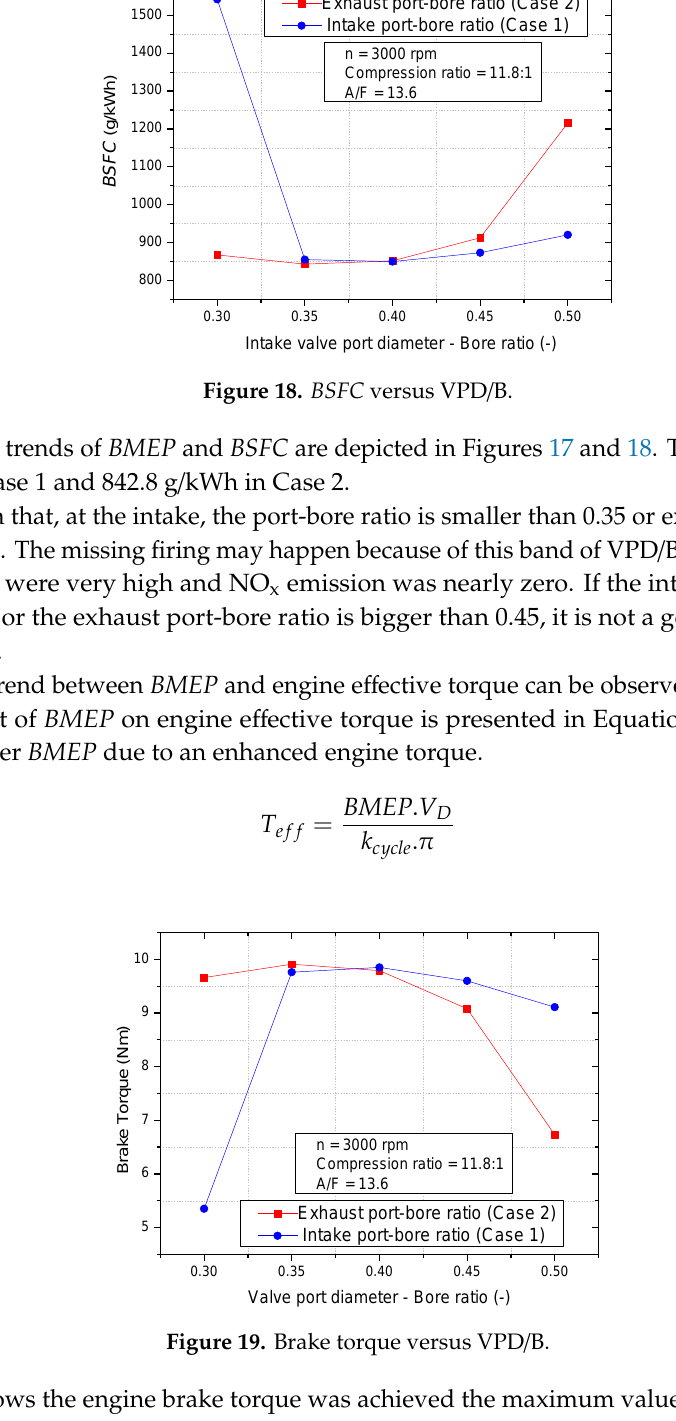
Figure 19. Brake torque versus VPD/B.